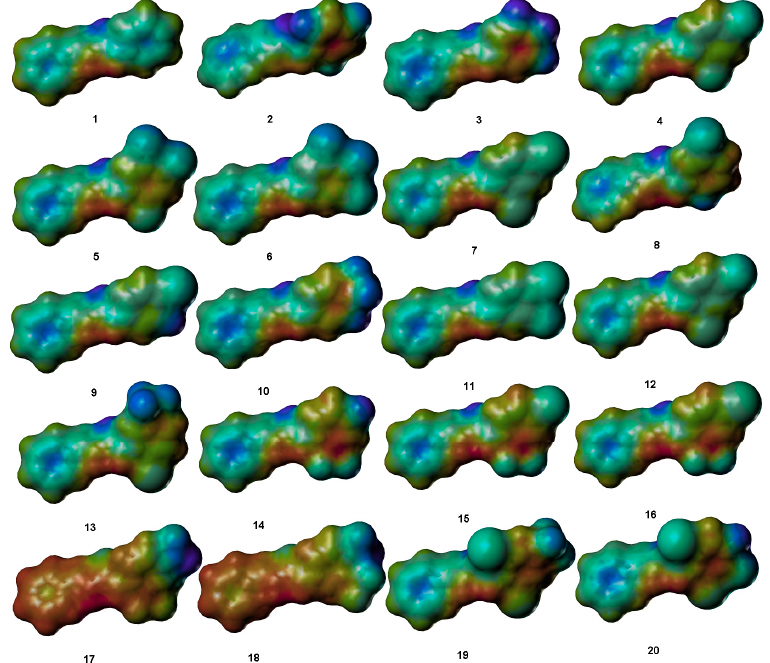
Figure 7. Molecular electrostatic potential topography of 1 – 20 anilides. Blue color codes negative values; red color codes positive MESP values.